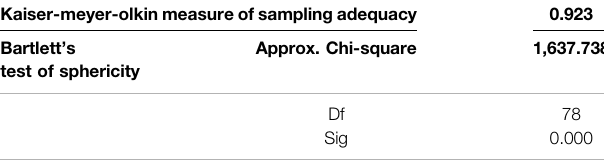
TABLE 1 | Kaiser-Meyer-Olkin and Bartlett ’ s test of